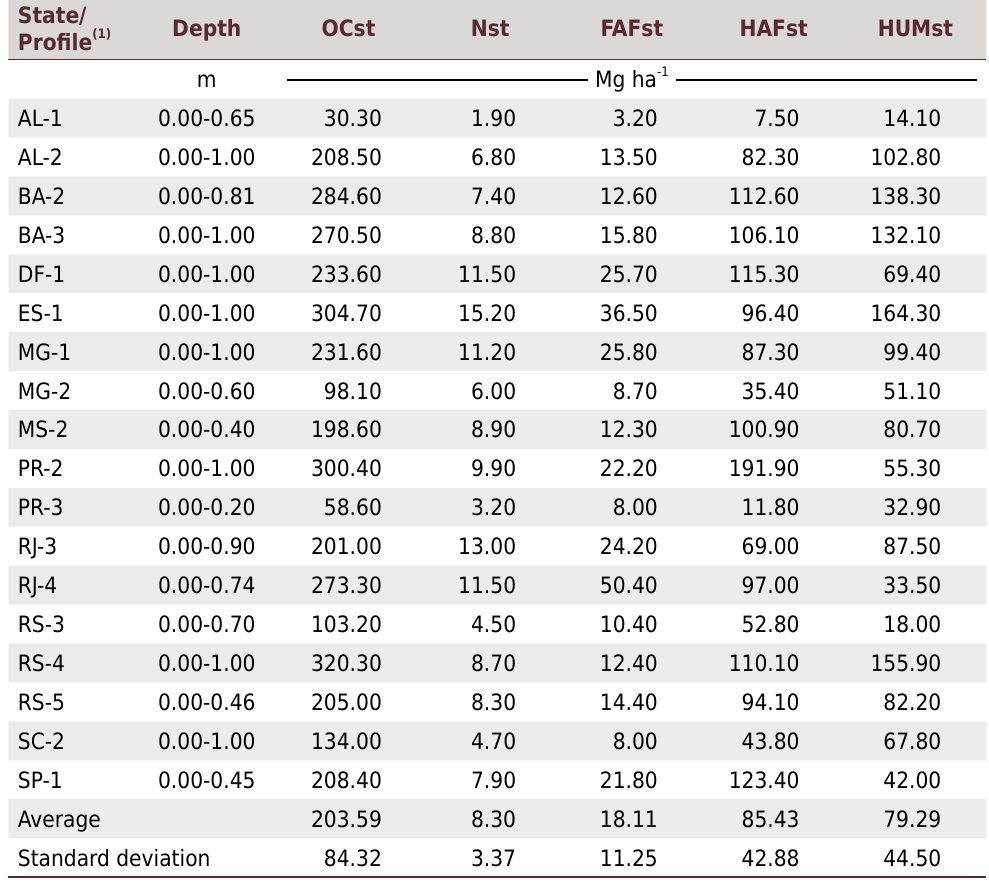
Table 5. Stocks of the organic carbon (OCst), nitrogen (Nst), and fulvic acid fractions (FAFst), humic acid fraction (HAFst), and humin (HUMst) in the Organosol